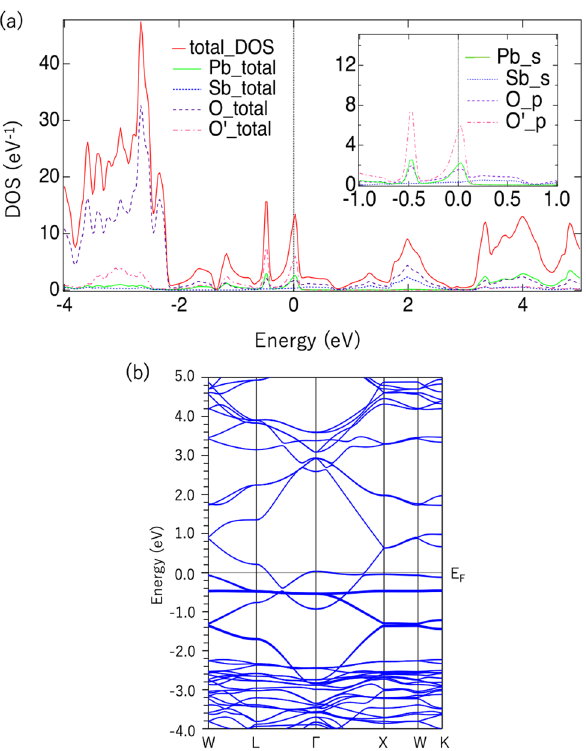
Figure 4. ( a ) DOS and ( b ) energy dispersion of Pb 2 Sb 2 O 7 with rhombohedral